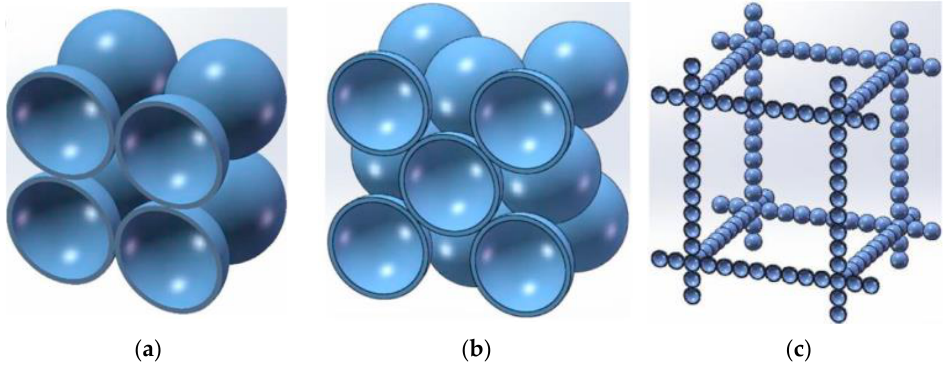
( b ) Figure 16. Cell: ( a ) Cell; ( b ) One-dimensional heat transfer. The thermal conductivity model of thermal insulation composites filled with aerogel particles was proposed by He et al. [69]. The corresponding models were established and the thermal conductivity equations based on the analysis of the heat transfer in the com- posite are derived in this paper. In Liu ’ s study [70], three kinds of nano-porous insulating materials with regular ge- ometric structures and controllable thermal conductivities, including a simple cubic pack- ing, a face-centered cubic packing, and a cubic array of intersecting spheres packing of